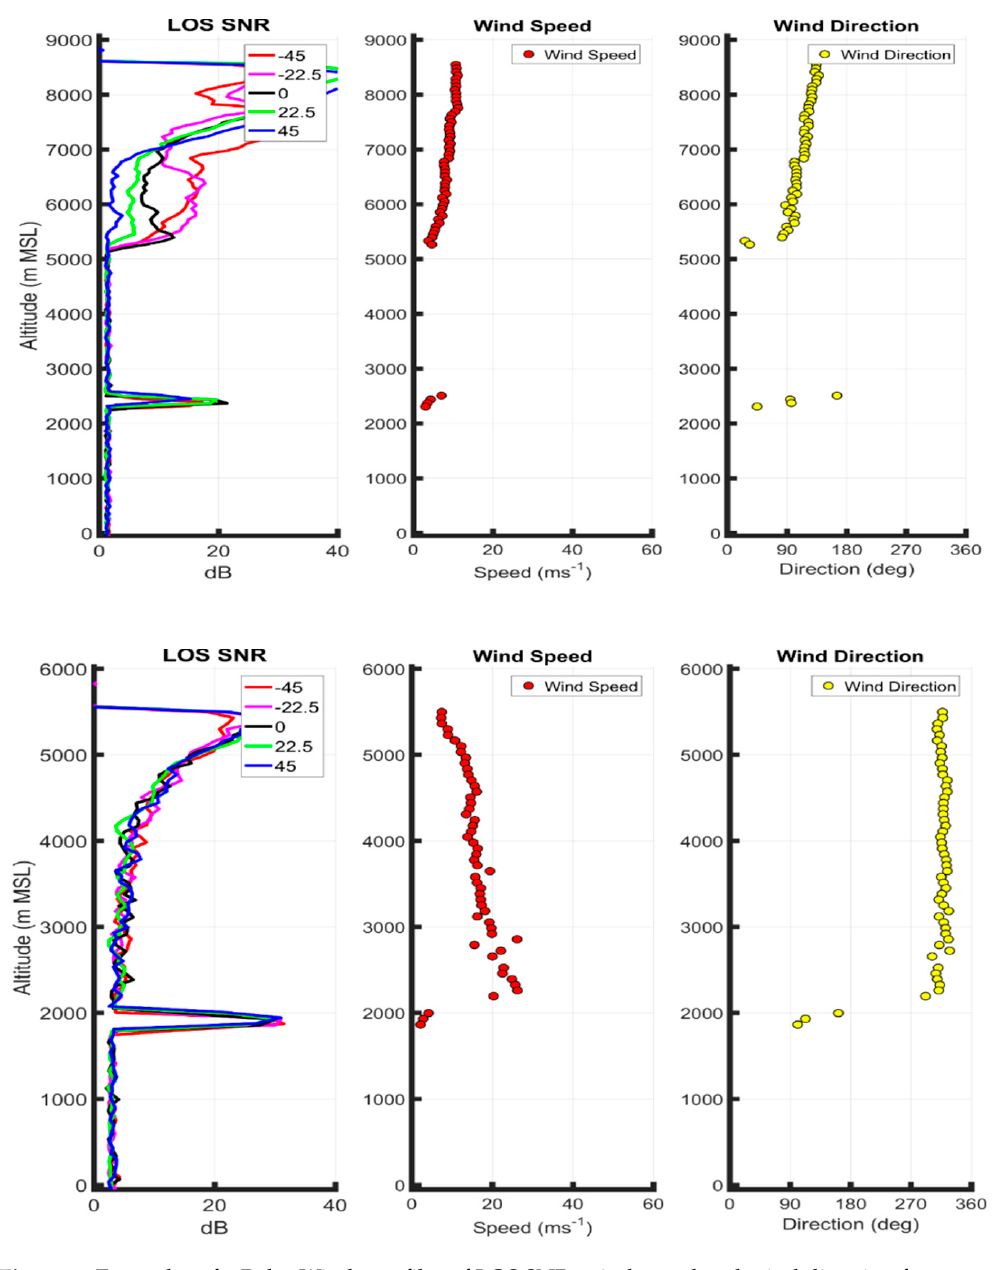
Figure 3. Examples of a Polar Winds profiles of LOS SNR, wind speed and wind direction from over the North Atlantic on 15 May 2015 18:05:35Z ( top ), and over the Greenland ice sheet on 16 May 2015 1511:37Z ( middle ) and 17 May 2015 15:36:37Z ( bottom ).